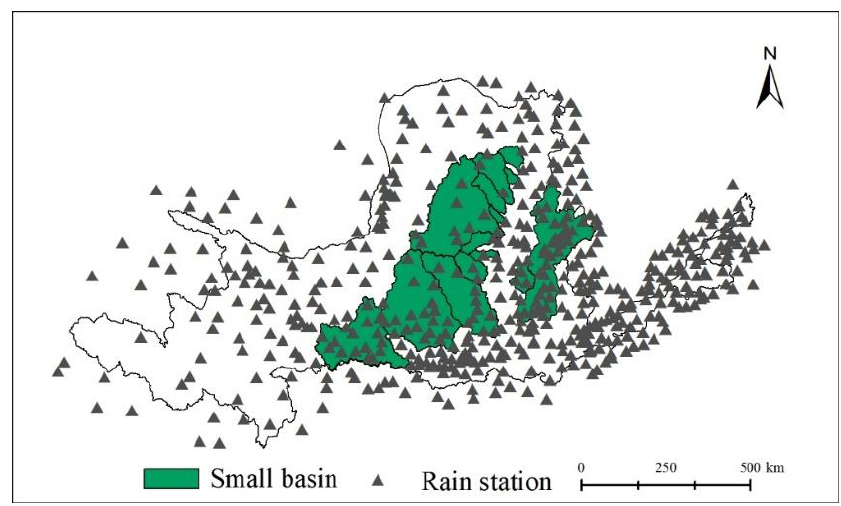
Figure A4. Spatial distribution of rain gauges during the years 2003–2015 in the YRB.